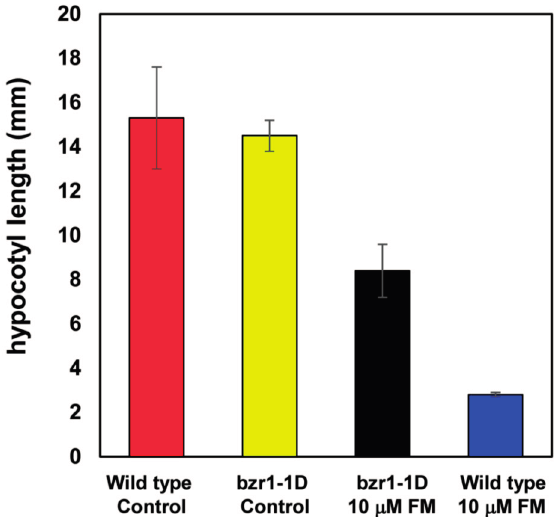
Figure 5. Sensitivity of Arabidopsis wild-type, bzr1-1D to FM. Seedlings of wild-type (Col-0) or bzr1-1D grown on ½ MS media in the dark for 5 days. Red bar: wild-type (Col-0) without FM treatment. Yellow bar: bzr1-1D mutant without FM treatment. Black bar: bzr1-1D mutant grown on ½ MS media containing 10 μ M FM. Blue bar: wild-type (Col-0) grown on ½